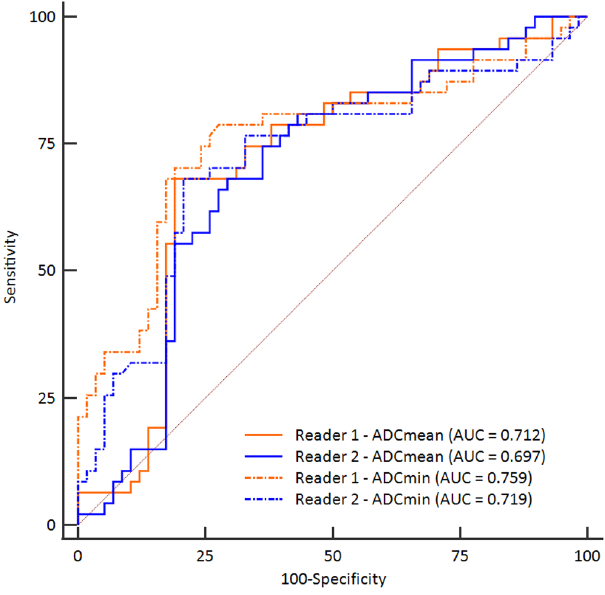
Figure 1. ROC curves of ADC mean and ADC min of reader 1 and reader 2 in training set. The plots were generated using MedCalc for Windows, version 19.0 (MedCalc Software, Ostend, Belgium).